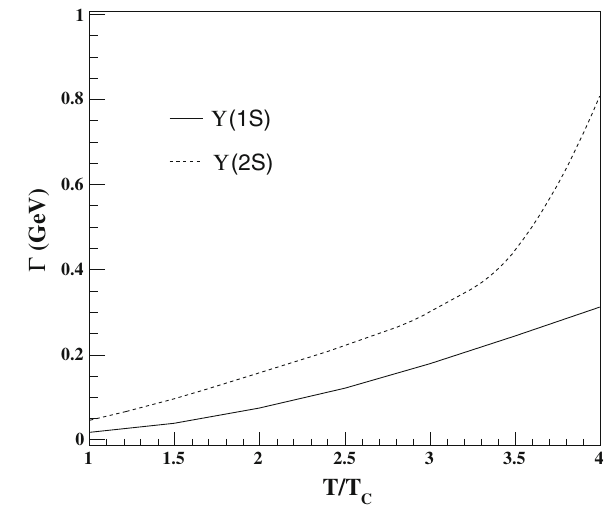
Fig. 12 Comparison of binding energy of ϒ( 1 S ) and J /ψ